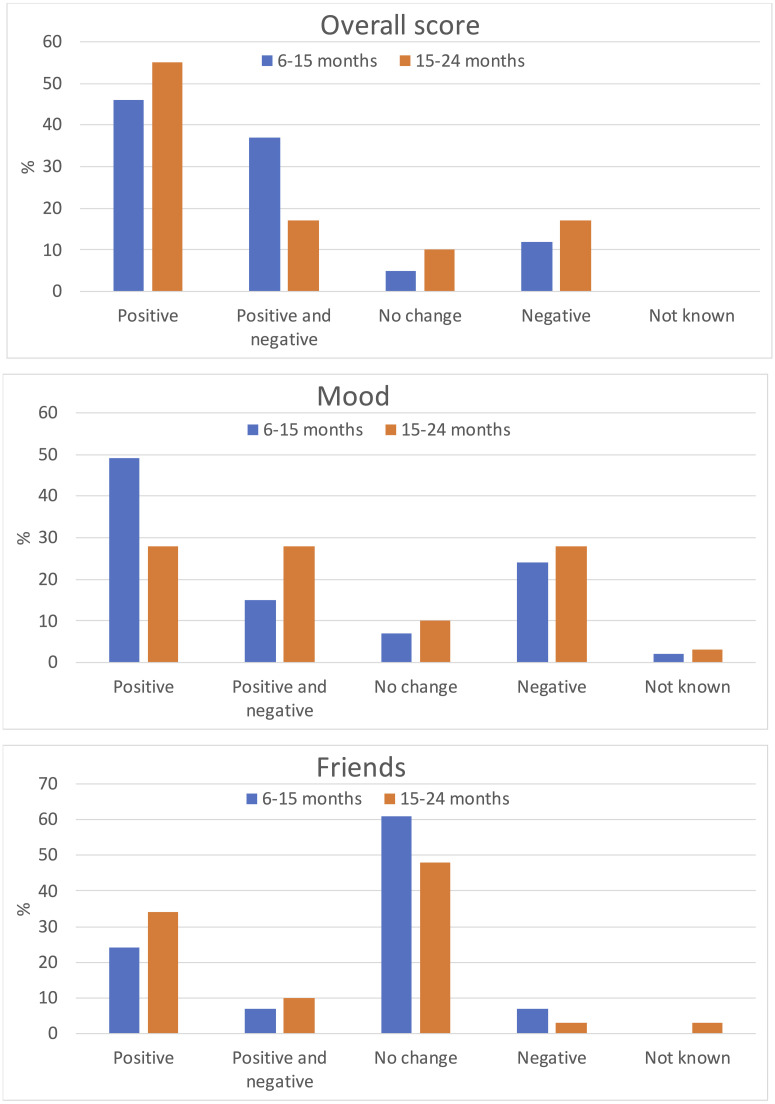
Ratings of change in life overall, mood and friendships at 6–15 months (n = 41) and 15–24 months (n = 29).